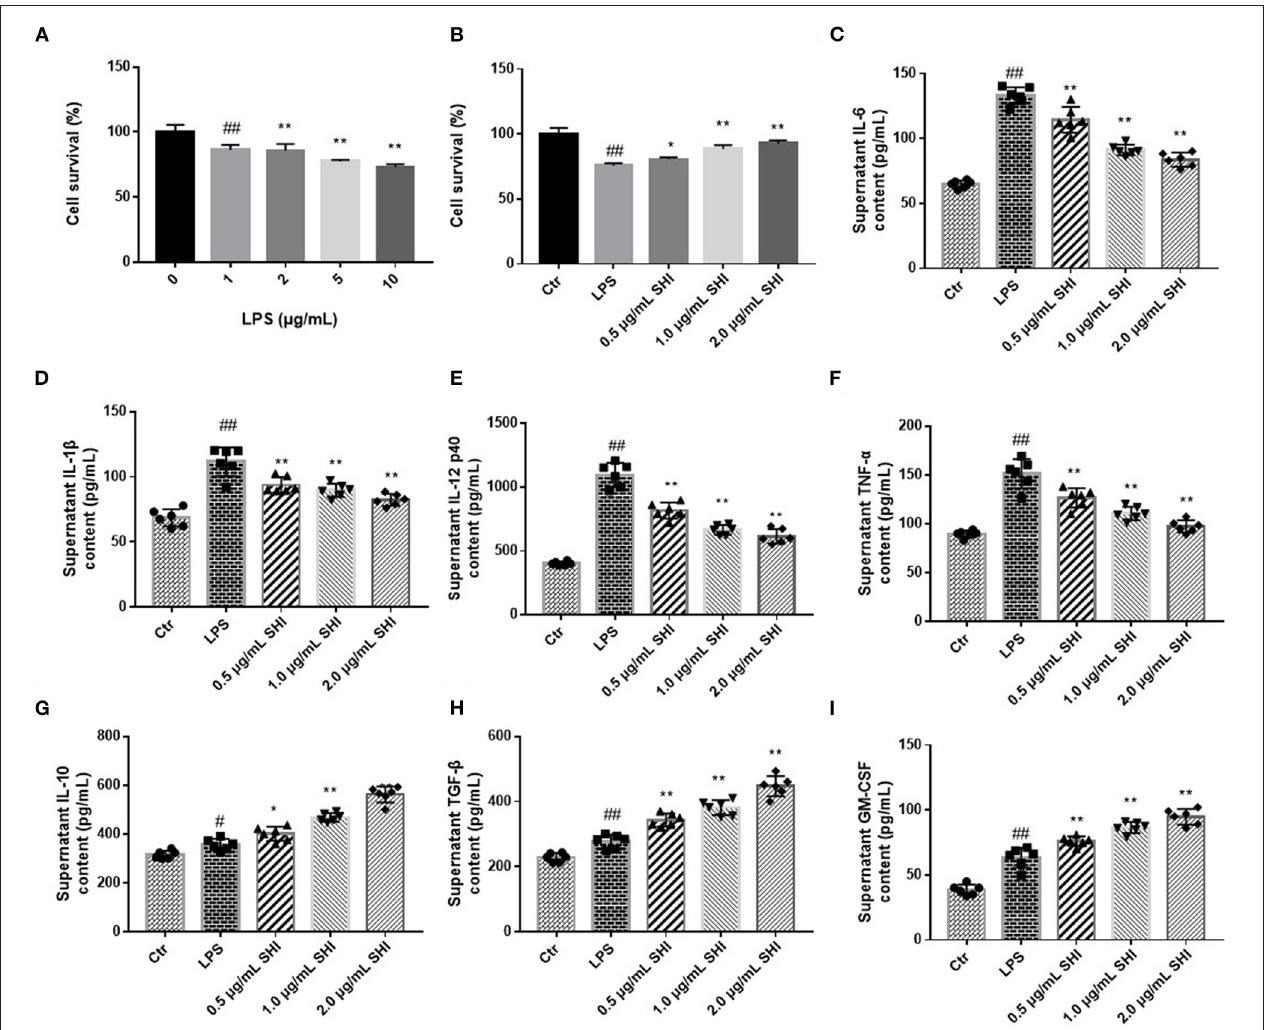
FIGURE 3 | Shionone protects RAW264.7 cells from LPS stimulation. (A) LPS concentration screening for cellular modeling ( n = 3). (B) Survival rate of RAW264.7 cells with 0.5, 1, and 2 µ g/mL Shionone ( n = 3). (C–I) ELISA to detect inflammatory factors (IL-6, IL-1 β , IL-12, TNF- α , IL-10, TGF- β , and GM-CSF) in LPS-treated RAW264.7 cells’ supernatants ( n = 6). Control group was used as a negative control and LPS group as a positive control. Results are expressed as ± SD for independent experiments, # p < 0.05 vs. Control group, ## p < 0.01 vs. LPS group, and * p < 0.05 vs. Control group, ** p < 0.01 vs. LPS group, one ANOVA followed by Tukey’s post-hoc